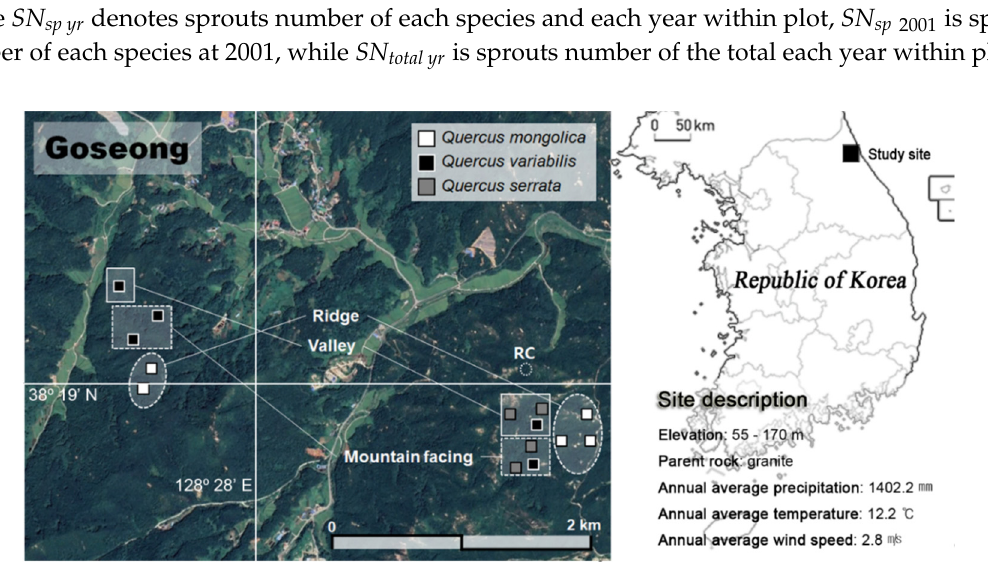
Figure 1. The geographic location and the study site. White filled squares, Quercus mongolica (Mongolian oak) dominant stand; Black filled squares, Quercus variabilis (oriental oak) stand; Gray filled squares, Quercus serrata (glandbearing oak) dominant stand; RC, right censoring.